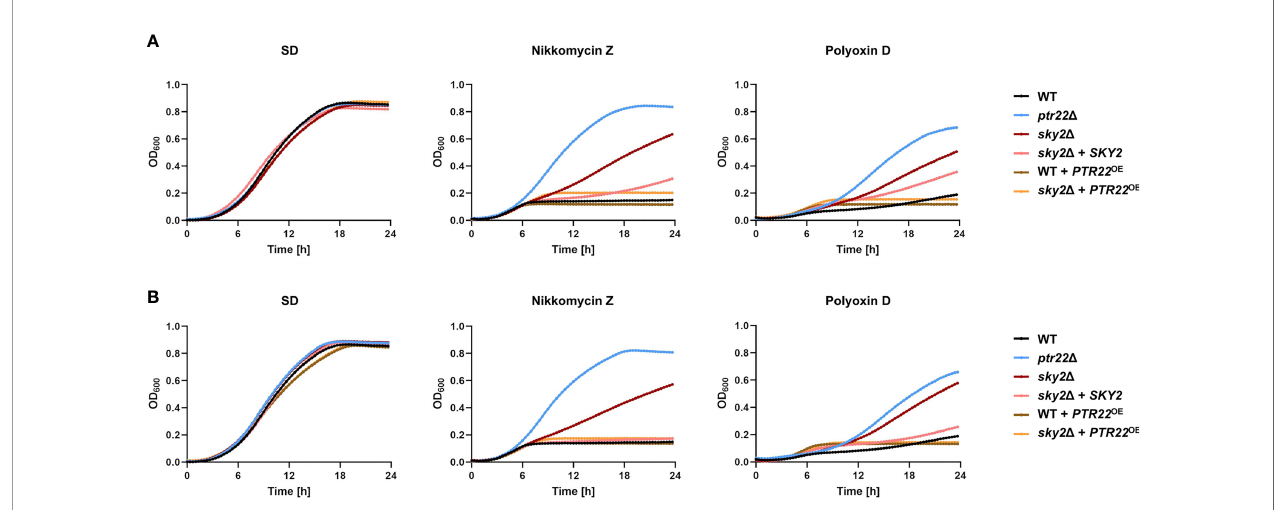
FIGURE 9 | Strains lacking SKY2 showed resistance to the antibiotics Nikkomycin Z and Polyoxin D. YPD overnight cultures were adjusted to an optical density (OD 600 ) of 0.02 in SD medium and SD medium supplement with either 140 µg/ml Nikkomycin Z or 130 µg/ml Polyoxin D and incubated at 37°C for 24 h. The growth (OD 600 ) was determined every 20 min at an optical density of 600 nm. Shown is the mean of each strain calculated from three technical replicates. For a better overview, the standard deviation is not shown. (A) The growth of the wild-type strain SC5314 and the A mutant strains is shown. (B) The growth of the wild-type strain SC5314 and the B mutant strains is